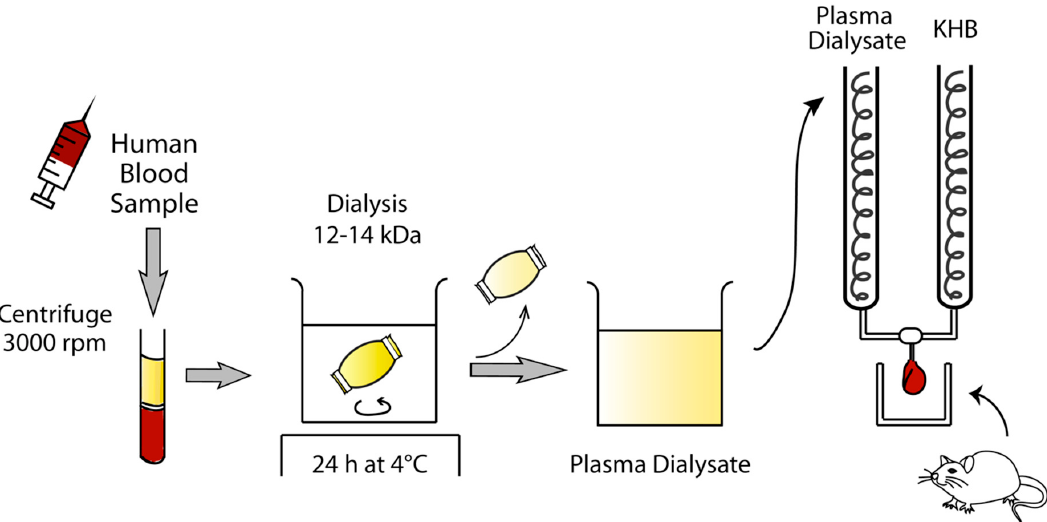
Figure 7. Plasma dialysate preparation and Langendorff rat heart perfusion system. KHB, Krebs– Henseleit